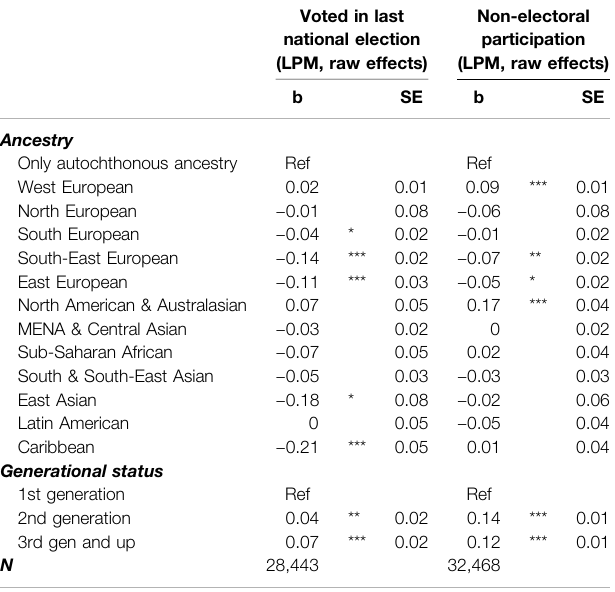
TABLE 8 | Regression models for political integration (main effects